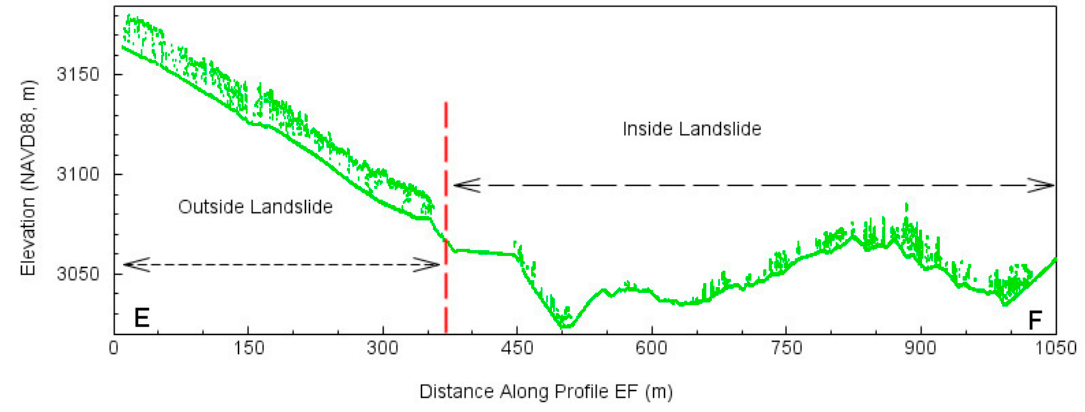
Figure 6. Typical terrain features and vegetation coverage inside and outside the sliding mass illustrated by ALS point clouds. The location of the profile EF is marked on Figure 3a.